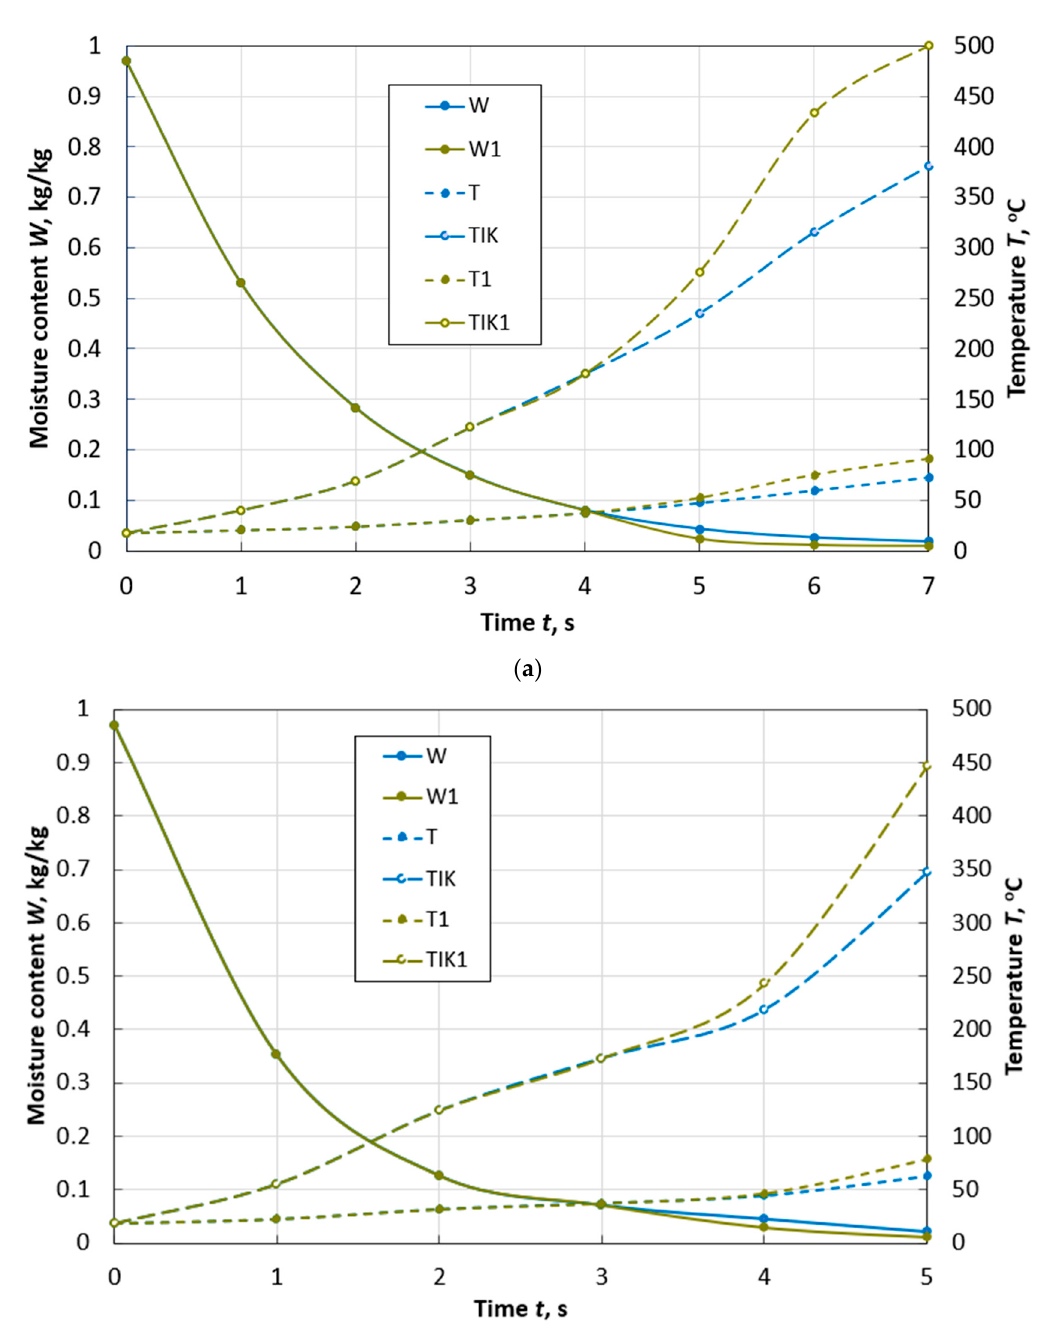
Figure 6. Changes over time in the average values of moisture content W and temperature T , temperature T IK on the surface of a spherical particle of peat with a diameter of d = 10 mm ( a ) and a diameter of d = 13 mm ( b ) during drying with and without taking into account thermal destruction ( W 1, T 1, T IK 1) in the flow of flue gases with parameters: Т e.m. = 500 ° С , w e.m. = 4 m/s, d e.m. = 12 g/kg of dry gas.